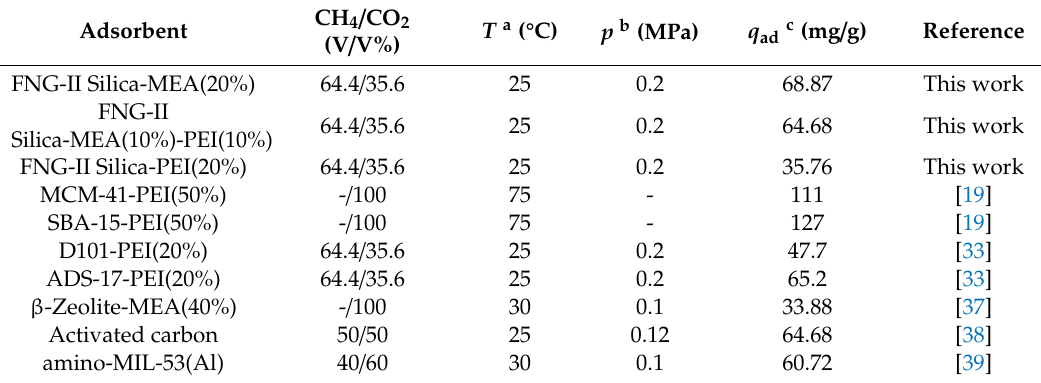
Figure 7. The breakthrough curves for CO 2 /CH 4. Table 2. Comparison of adsorption capacities among various amine-modified